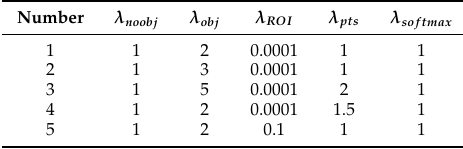
Table 6. Models with different parameters. We used five groups of loss weights to get different parameter models and compared their recognition accuracy.